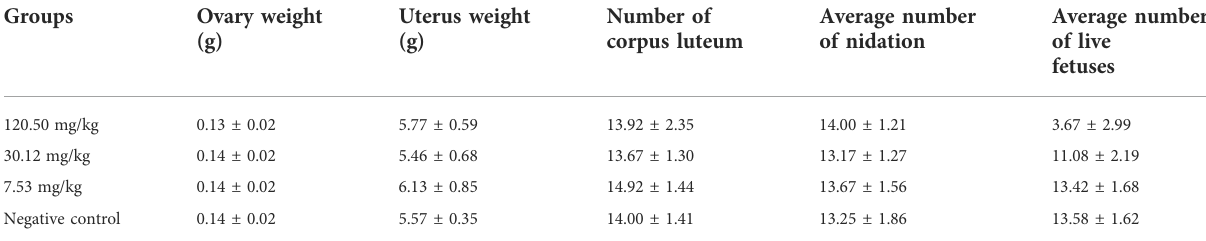
TABLE 3 Effect of MPTA on reproductive function in rats (n = 12).